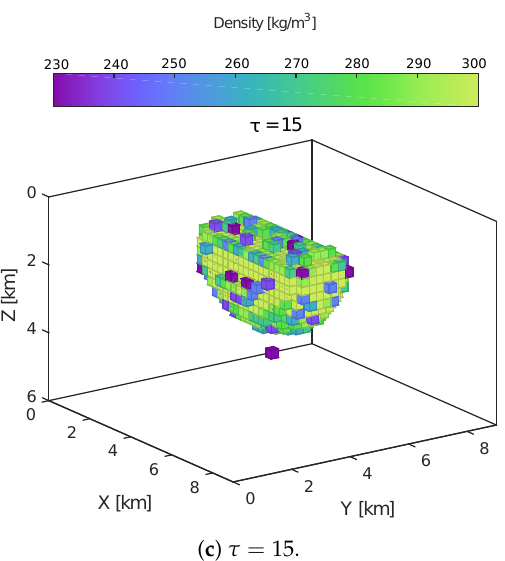
Figure 35. Behavior of growth algorithm as a function of τ